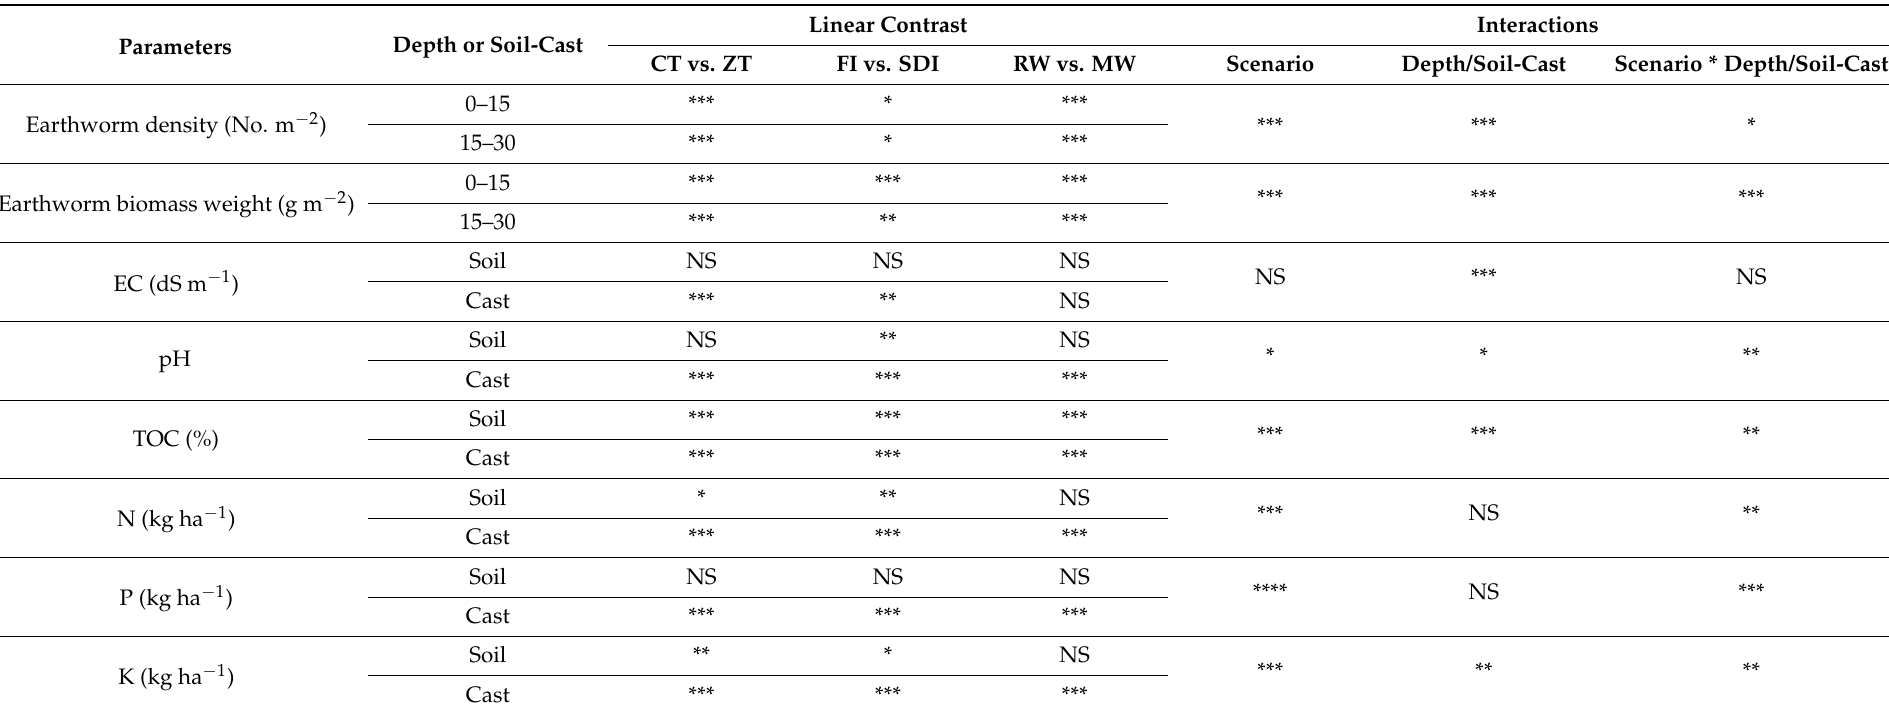
Table 4. Significance effect of different management practices and their linear contrast and interactions on earthworm density, earthworm biomass weight, physio-chemical, and enzymes’ activities under long-term CSA-based management